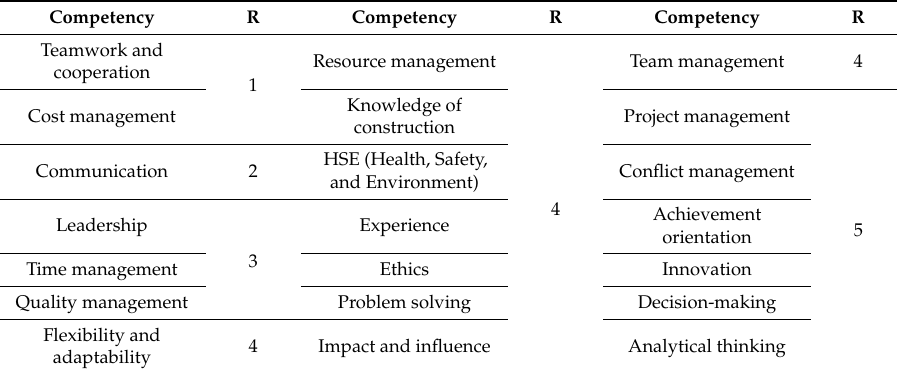
Table 1. Project managers’ key competencies in construction